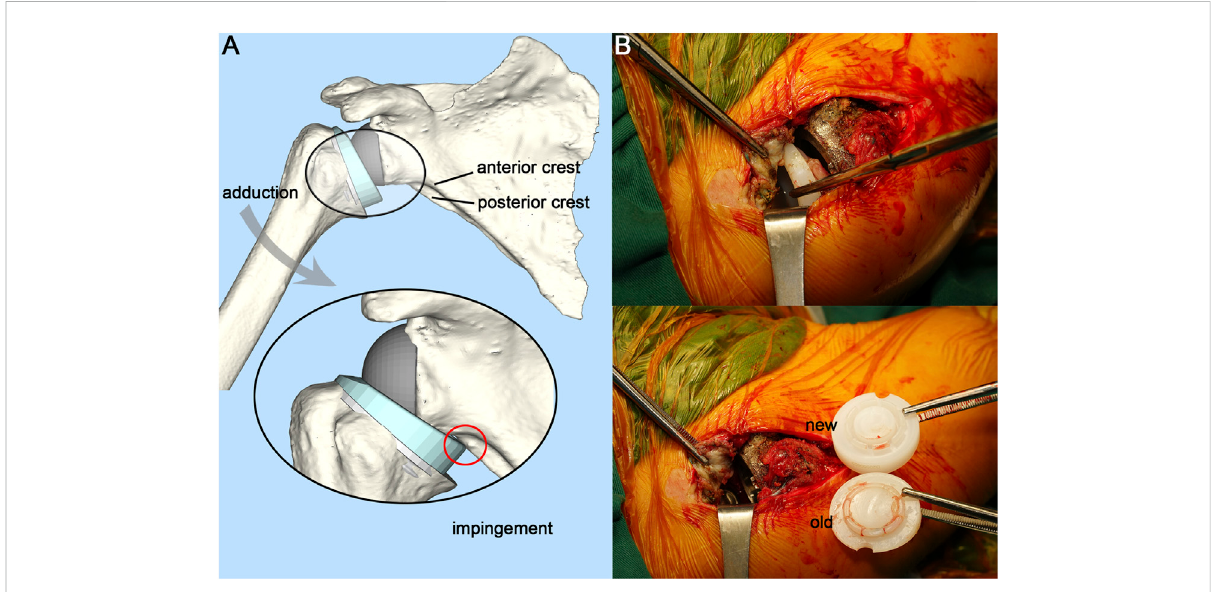
FIGURE 1 Illustration of adduction impingement and intraoperative photograph. (A) , Illustration of adduction impingement. (B) , Exposed joint cavity with visible polyethylene liner dissociation and intraoperative comparison of the new and the old